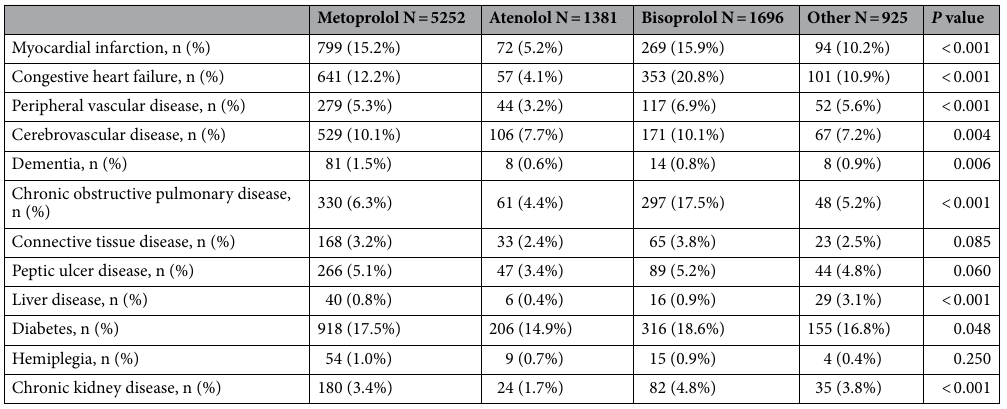
Table 2. Comorbidities. N, Total number of